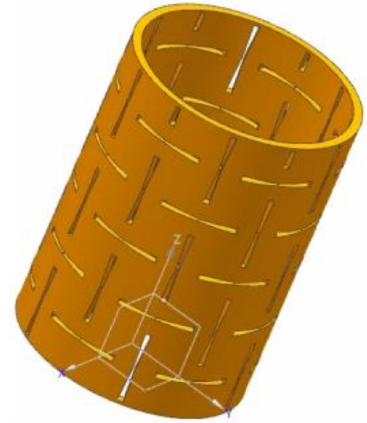
Figure 6. Three-dimensional NPR spacer